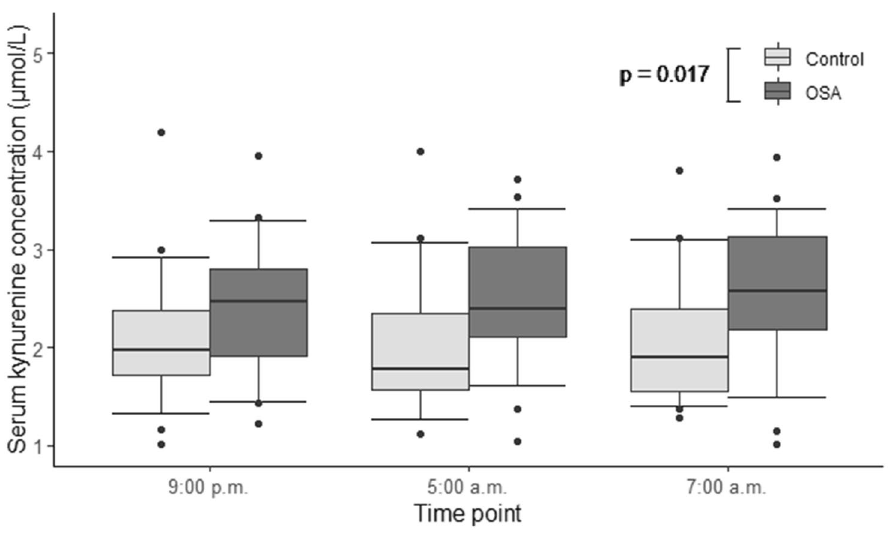
Figure 3. Serum kynurenine concentrations of patients with moderate-to-severe obstructive sleep apnea (OSA) (n = 31) and control individuals (n = 32). General linear model for repeated measures was used on rank transformed data. Kynurenine concentrations were significantly higher in OSA patients, compared to controls ( p = 0.017).